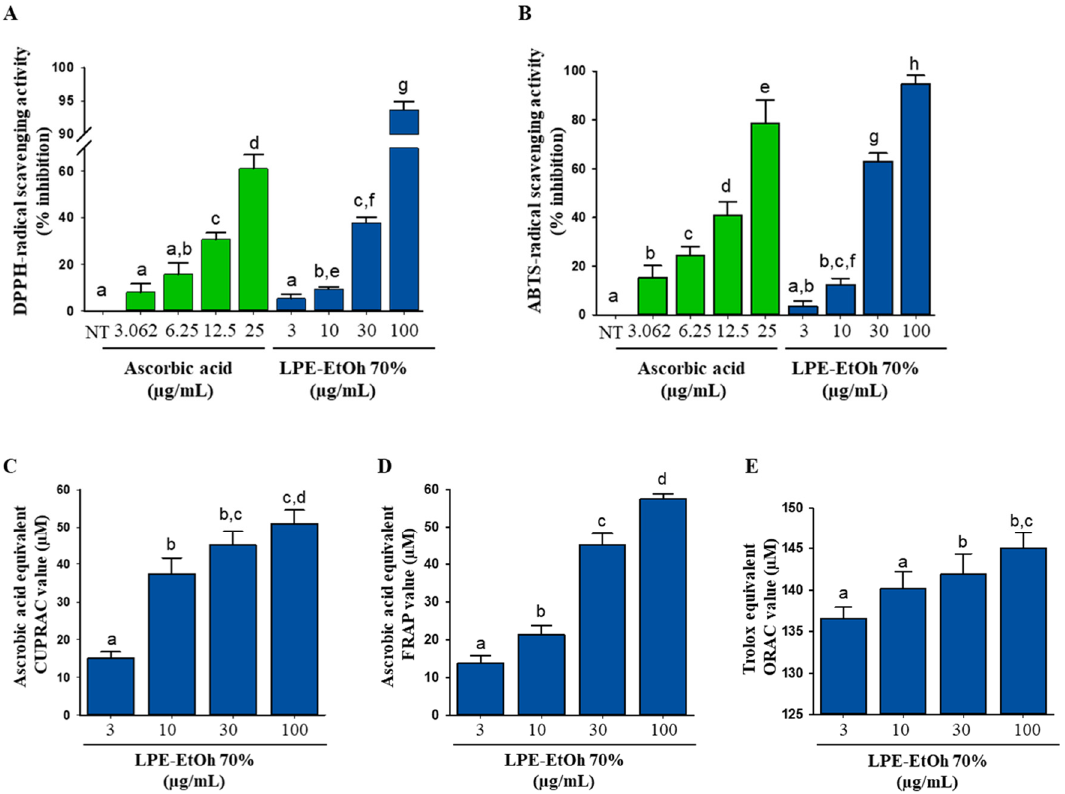
Figure 2. Radical scavenging effects of Lablab purpureus 70% ethanolic extract (LPE) (2 µL). The 2,2-diphenyl-1-picrylhydrazyl (DPPH)-radical scavenging assay ( A ), ABTS-radical scavenging assay ( B ), cupric reducing antioxidant capacity (CUPRAC) assay ( C ), ferric reducing antioxidant power (FRAP) assay ( D ) were performed determined concentrations of the LPE (3–100 µg/mL), and ascorbic acid were used as standard. The oxygen radical absorbance capacity (ORAC) activities of the samples were calculated by subtracting the area under the blank curve from the area under the sample curve to obtain the net area under the curve (net AUC) ( E ). Statistical values are expressed as the mean ± SD ( n = 3). All the tests were performed in triplicate. Different letters stand for statistically significant each other ( p < 0.05) performed by one-way ANOVA followed by Tukey’s test. Green color means ascorbic acid-treated group as a positive control and blue color means sample treated groups (LPE).